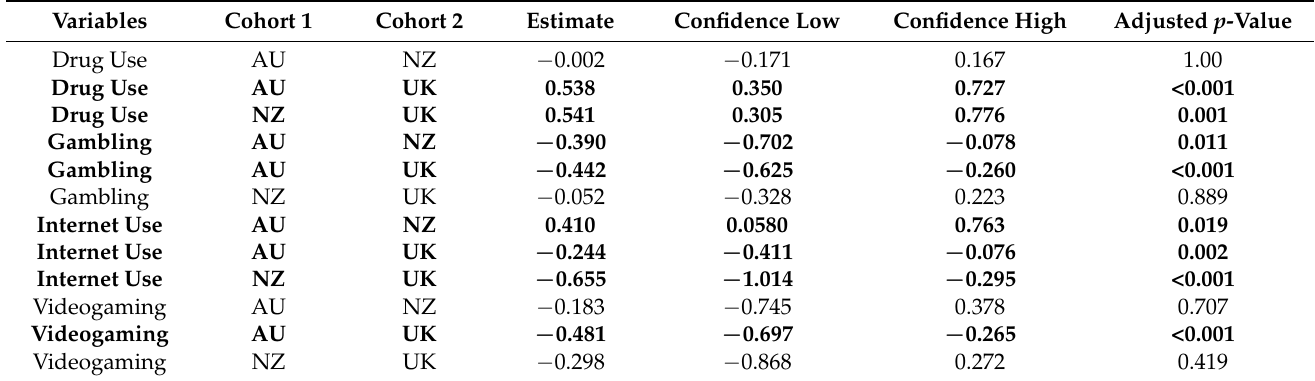
Table 6. At-risk profile post-hoc games Howell pairwise comparisons.